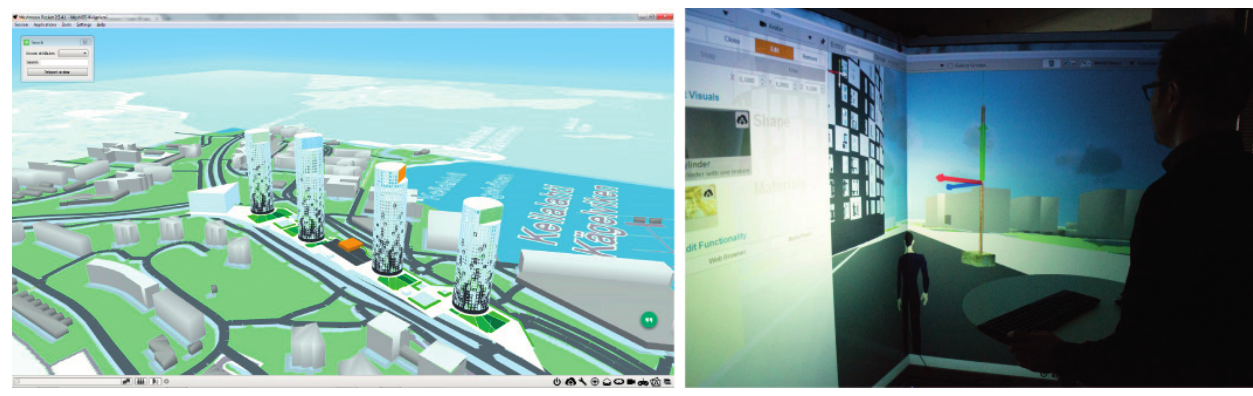
Figure 10. Left : A building model imported into the scene. Right : User interacting with the model in a